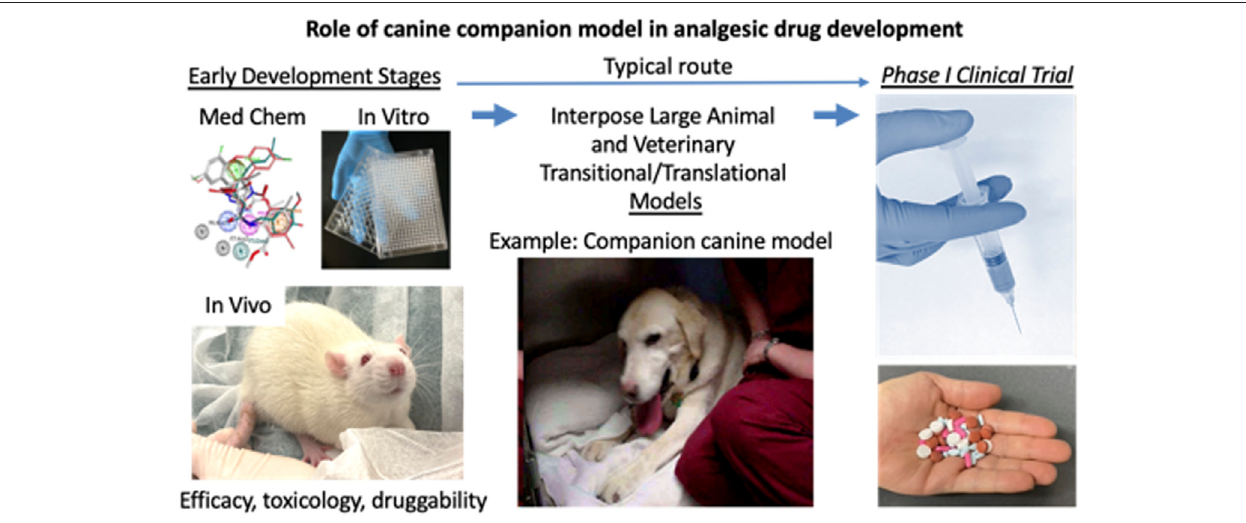
FIGURE 1 | Role of companion canine model in analgesic drug development. The drug development process progresses from left to right. The early development steps include, discovery, medicinal chemistry, in vitro screening, in vivo testing in rodent models, and optimization for target engagement, adsorption, distribution, metabolism, excretion. Usually, after manufacturing processes and toxicology are conducted, the candidate molecule goes into phase I testing. What is often lacking, despitepositiveresultfrommouseorratstudiesisaclearindicationofwhetherthecompoundproducesanalgesiainclinicalpainstates.Thesewouldbeindications arisingfromnaturaldiseases.Toaddressthisgaptheveterinarycompanioncaninemodelisinterposedbetweenthetwomajormilestonesindrugdevelopment.Thetwo main clinical conditions that have been used for analgesic drug evaluation are pain from osteosarcoma and osteoarthritis. These conditions both impact motor activity and performancewhichprovideobviousendpoints forevaluation.Sincethepainfromtheconditionsaffectsactivities ofdailyliving,theownershavemultipleparameters from which to judge improvement in their animal ’ sbehavior. Formal, validated scales have been developed for evaluation ofboth pain severity and pain interference with activity (Brown et al., 2007; Brown et al., 2008; Brown et al., 2009; Brown et al., 2010; Brown et al., 2013a; Brown et al., 2013b; Brown, 2014). Other parameters available include objective measures such as force plate determinations of weigh bearing and analysis of video recordings. Because a weight bearing limb (or limbs) is involved in both disorders and either a fore or hind limb can be affected, gait and force plate measurements sometimes can be dif fi cult to obtain in a reproducible or reliable manner (Iadarola et al., 2018). However, the range of potential available endpoints is broad enough to be adapted to a variety of